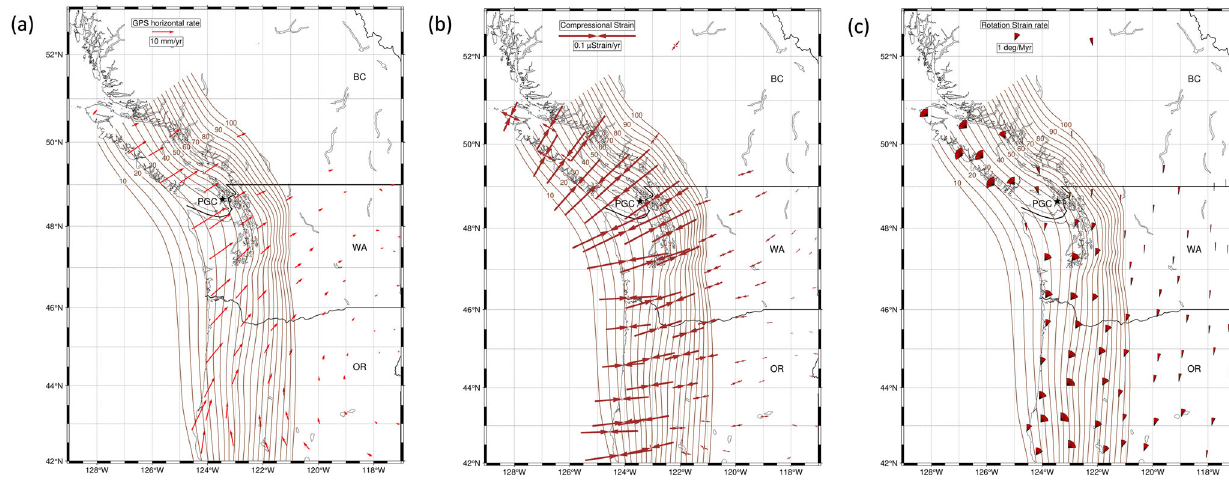
Fig. 4 GPS Velocity fi eld and calculated strain components. a Horizontal velocity fi eld, ( b ) principal strain, and ( c ) rotation rates from 533 stations in the Paci fi c Northwest region gridded in blocks with 1.0° latitude and 0.8° longitude dimensions. Contours show the Cascadia plate interface geometry based on the slab contours of McCrory et al. 72 . The maps were created by using the Generic Mapping Tools (GMT) 71 .